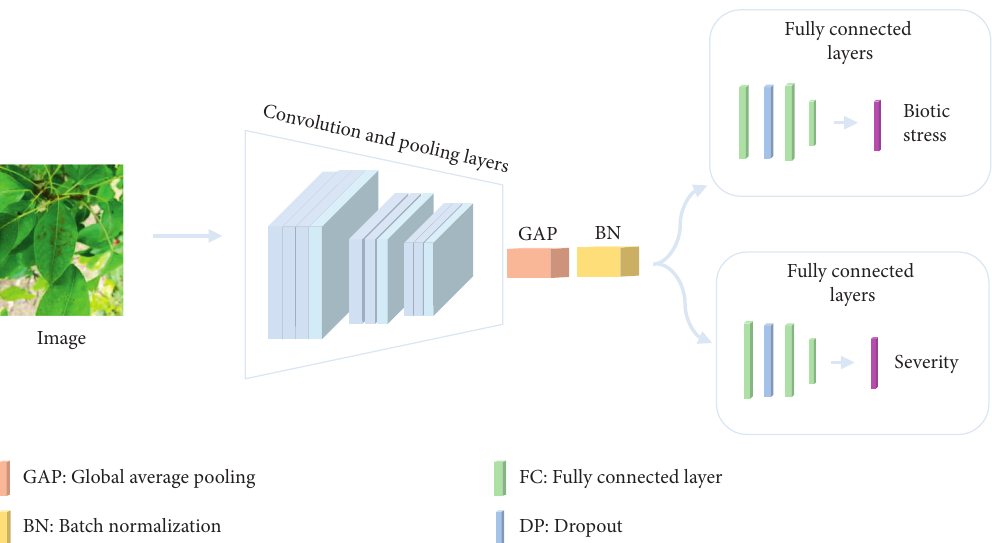
Figure 5: A schematic of the proposed image-based multioutput convolutional neural